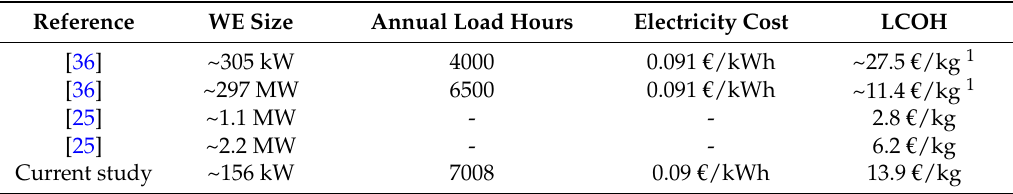
Table 7. Results and assumptions from selected